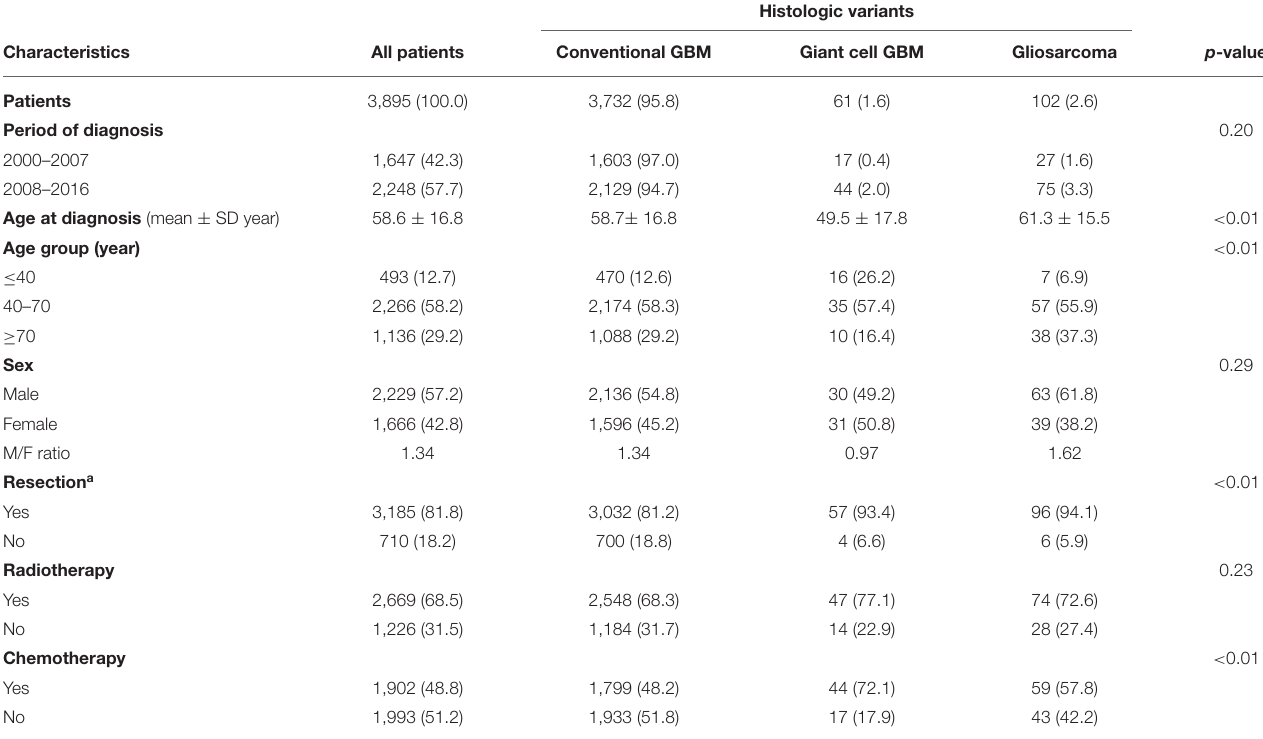
TABLE 1 | Demographic and clinical characteristics of patients diagnosed with glioblastoma and its histologic variants in 2000–2016, Taiwan.